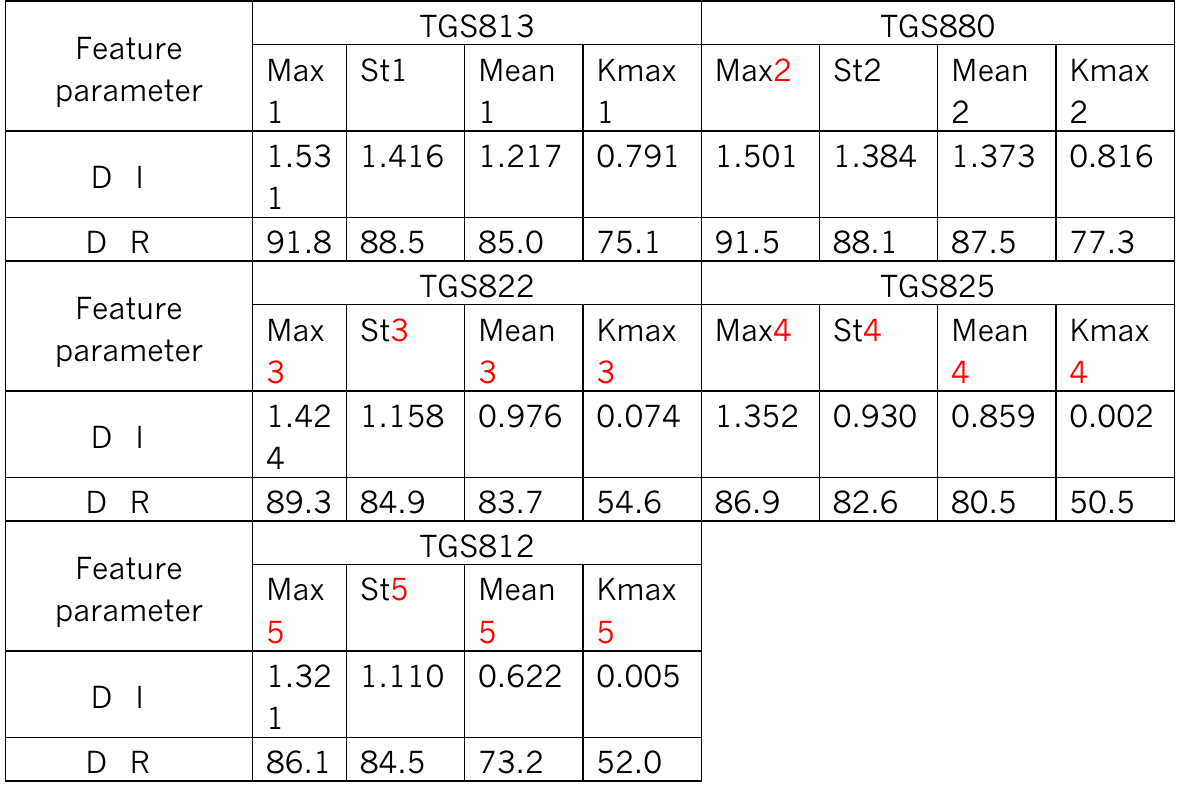
Table 2. D.I. and D.R. of 20 feature